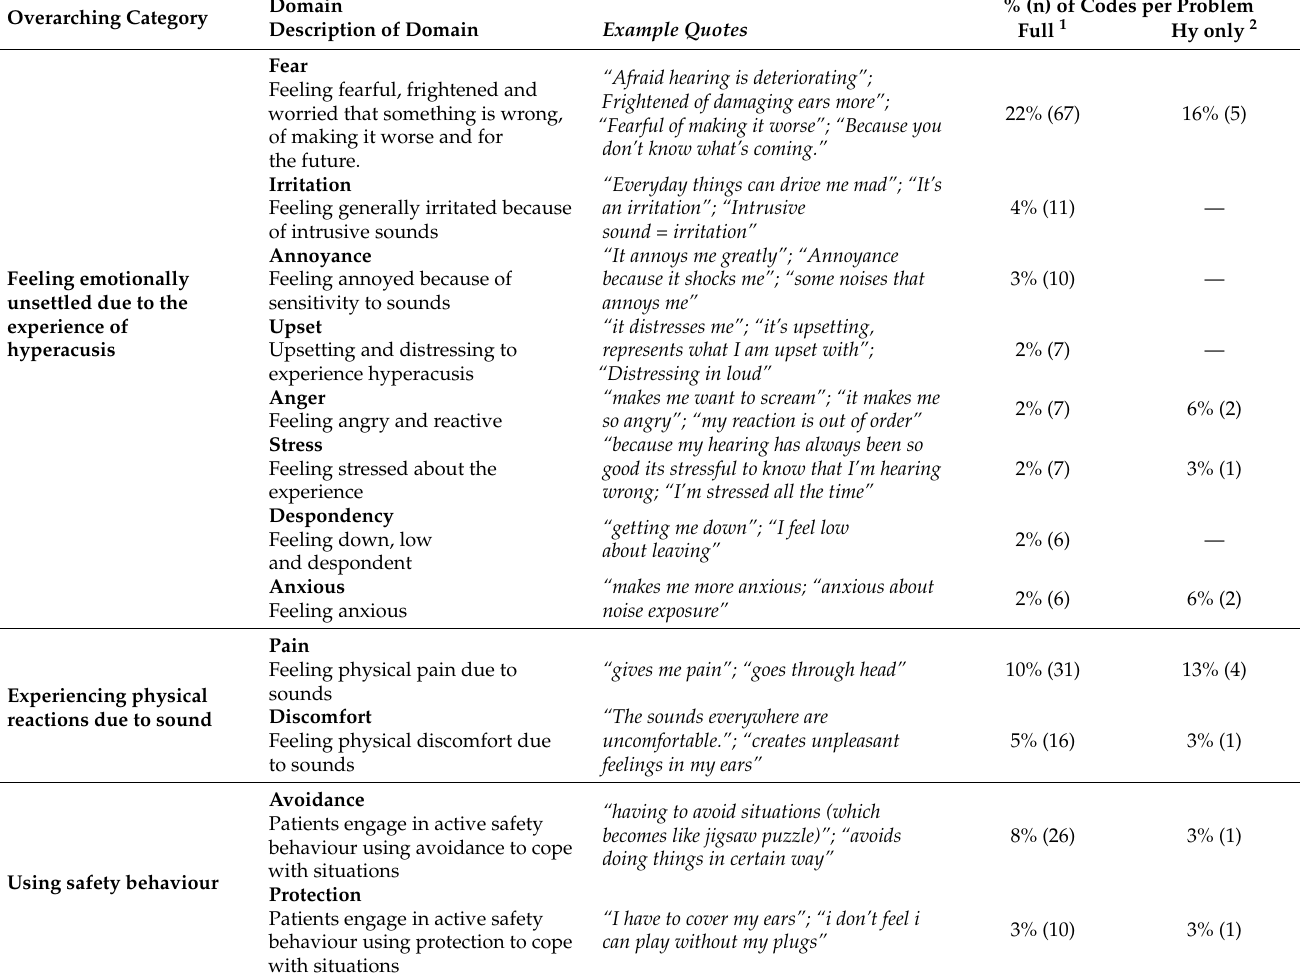
Table 1. The 25 domains for hyperacusis problems and example